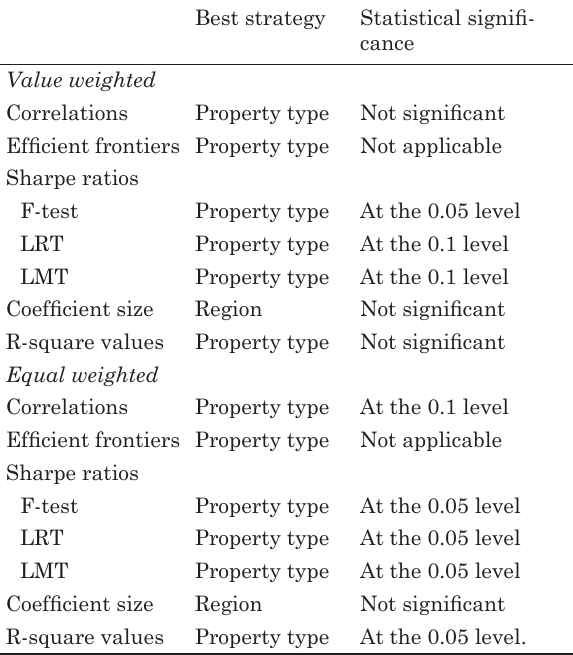
Table 14. a comparison of methods